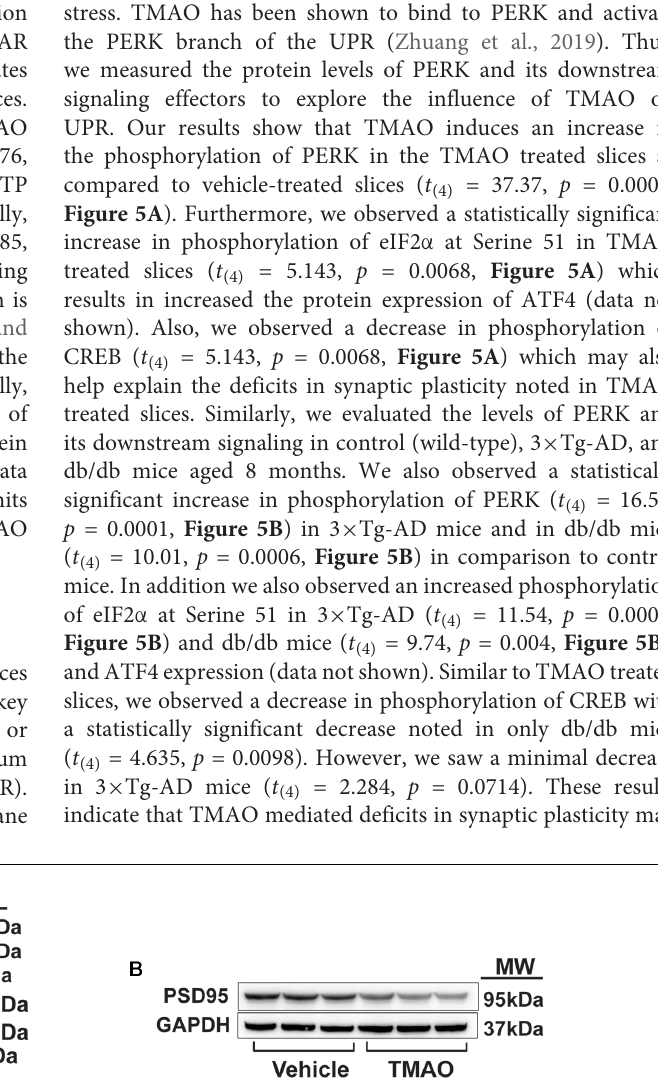
Frontiers in Molecular Neuroscience |